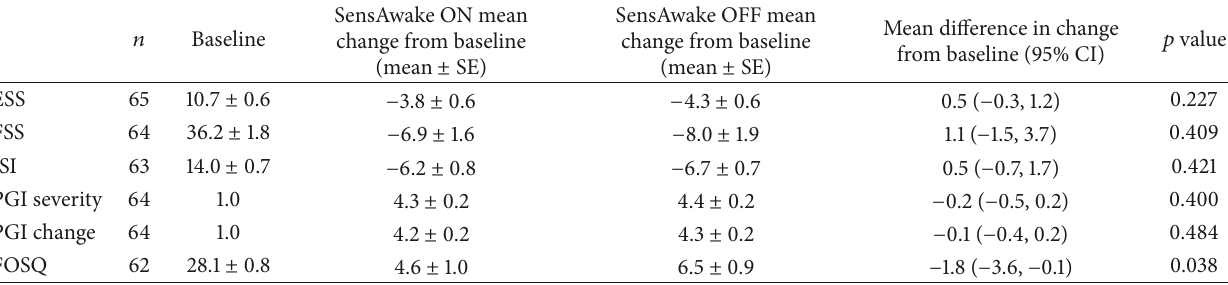
Table 2: Subjective sleep quality in CPAP devices with and without